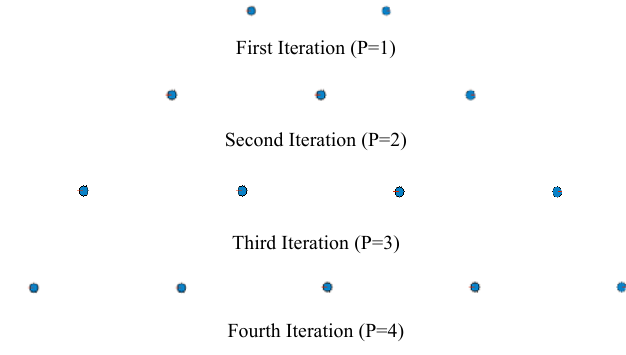
Figure 2. First four iterations of linear fractal array antenna for an expansion factor of